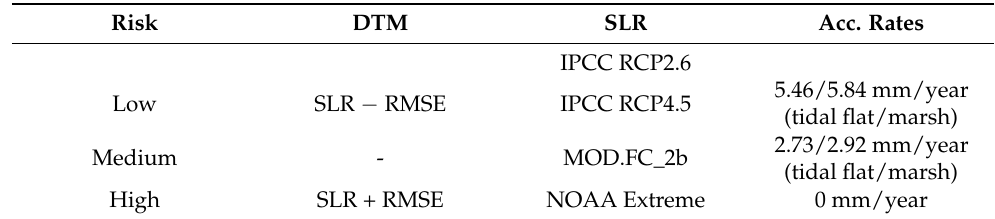
High SLR + RMSE 0